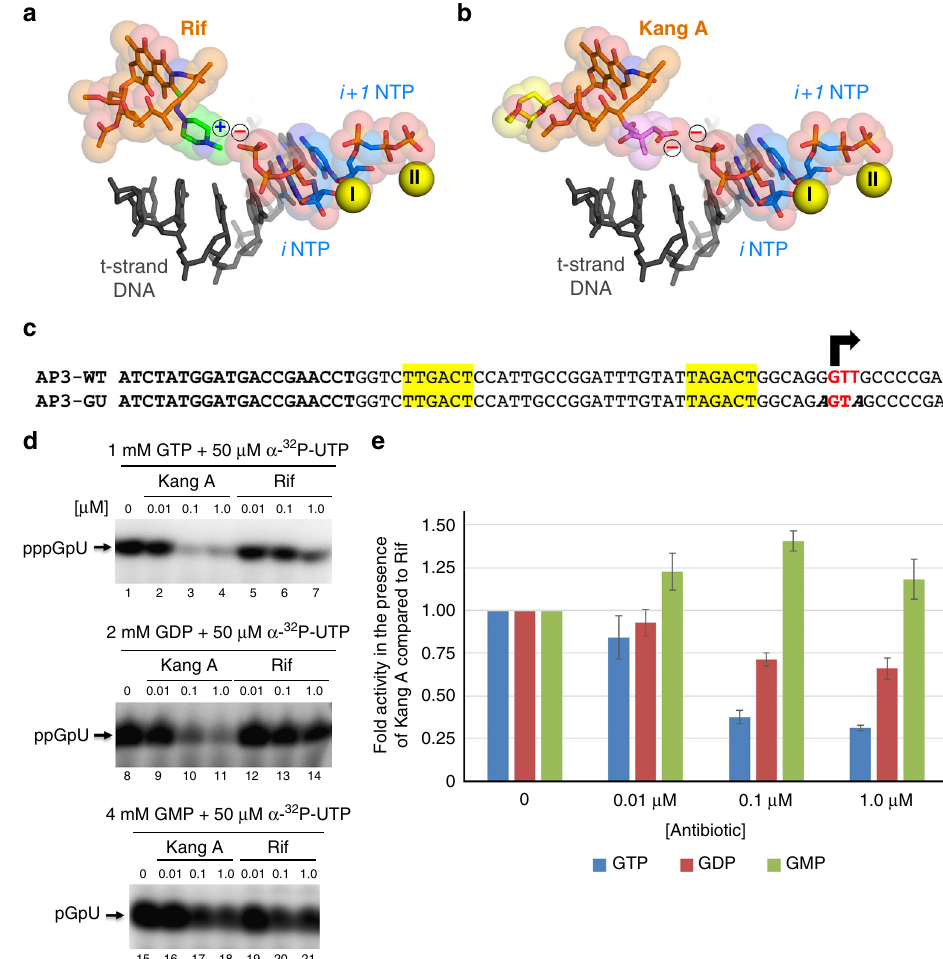
Fig. 6 Structural basis for Kang A inhibition of i NTP binding. a View of the RNAP active site from the T. thermophilus de novo initiation complex (4Q4Z) 50 with bound Rif superimposed. Shown is the t-strand DNA from + 1 to − 5 (dark gray), the initiating NTP substrates ( i site NTP, ATP; i + 1 NTP, CMPCPP; blue carbon atoms) and two Mg 2 + -ions (yellow spheres; Mg 2 + I is the Mg 2 + -ion chelated in the RNAP active site, Mg 2 + II is bound to the i + 1 NTP). Rif is color-coded as in Fig. 4b. Rif and the NTPs are also shown with transparent van der Waals surfaces. The blue “ + ” denotes the positive charge of the Rif piperazine moiety, while the red “ − ” denotes the negative charge of the i NTP γ -phosphate. b Same as (A) but showing Kang A (colored as in Fig. 4c). The negative charge of K-acid is brought in close proximity to the negative charge of the i NTP γ -phosphate. c Sequence of AP3-GU promoter template used in in vitro abortive initiation assays monitoring the effect of Kang A or Rif on RNA dinucleotide synthesis with GTP, GDP, or GMP as the 5 ′ -initiating nucleotide. The initial transcribed sequence of the Mtb AP3 promoter (top) was engineered to allow only RNA dinucleotide synthesis (5 ′ -GU-3 ’ ) in the presence of GTP, GDP, or GMP as the 5 ′ -initiating nucleotide and UTP. The mutated bases are denoted in bold italic (AP3-GU, bottom). d Kang A or Rif inhibition of in vitro abortive initiation of RNA dinucleotide synthesis using the AP3-GU promoter template; (top) 1 mM GTP + 50 μ M α - 32 P-UTP; (middle) 2 mM GDP + 50 μ M α - 32 P-UTP; (bottom) 4 mM GMP + 50 μ M α - 32 P-UTP. e Plotted is the RNA dinucleotide synthesis with Kang A relative to the same condition with Rif, normalized by the results with no antibiotic. Kang A has a strong inhibitory effect with GTP as the 5 ′ -initiating nucleotide (blue bars), a weaker effect with GDP (red bars), and no inhibitory effect with GMP (green bars). The error bars denote standard error of four